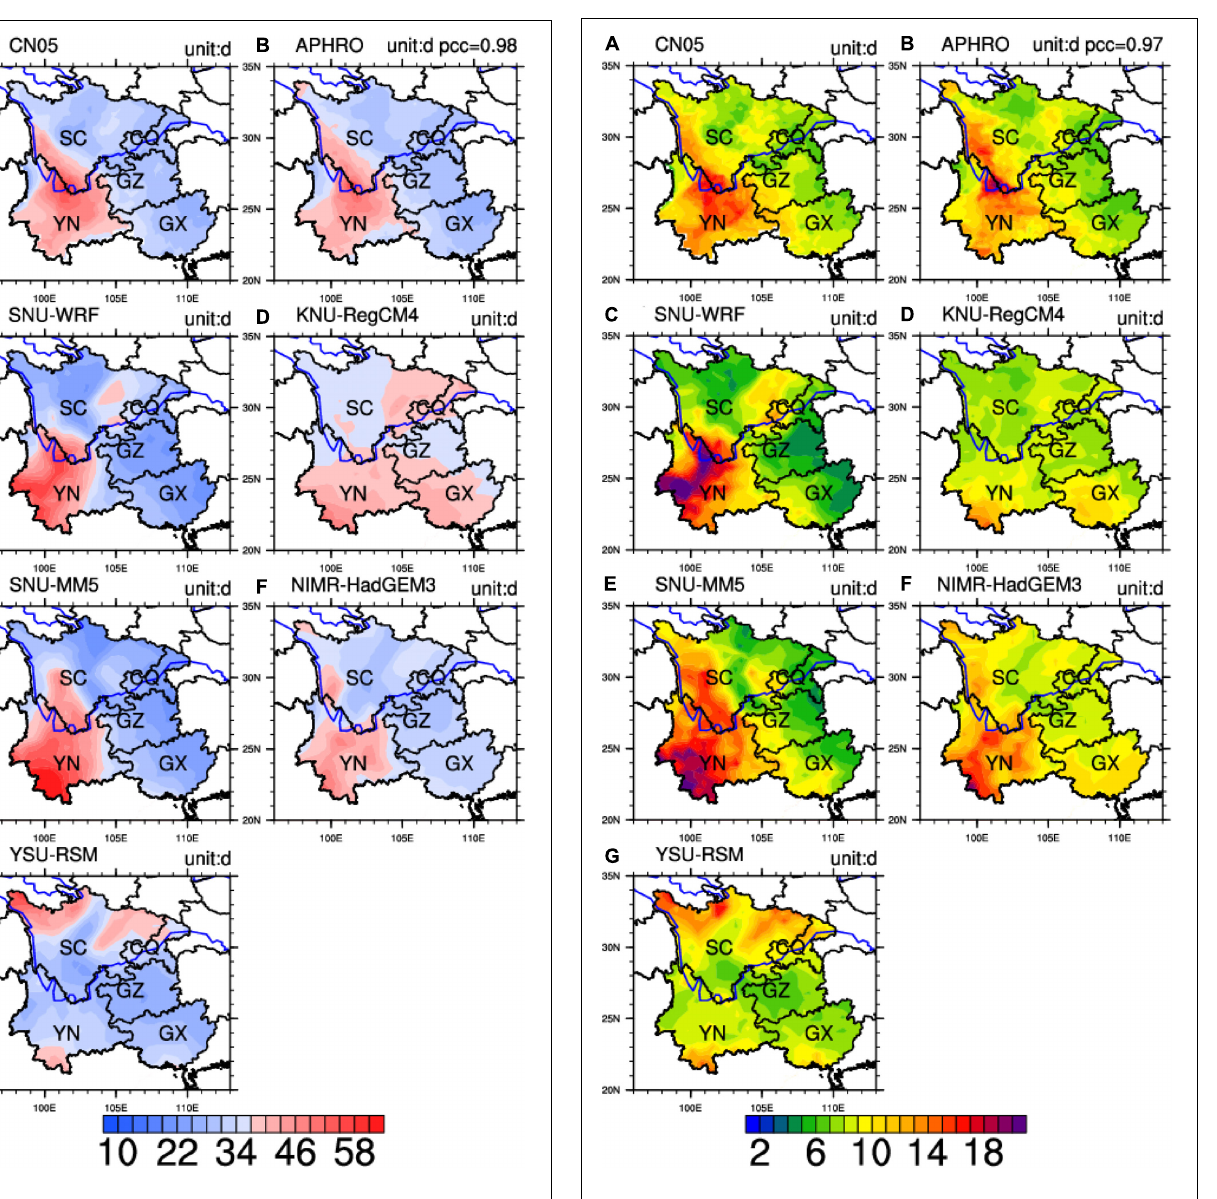
Frontiers in Earth Science |